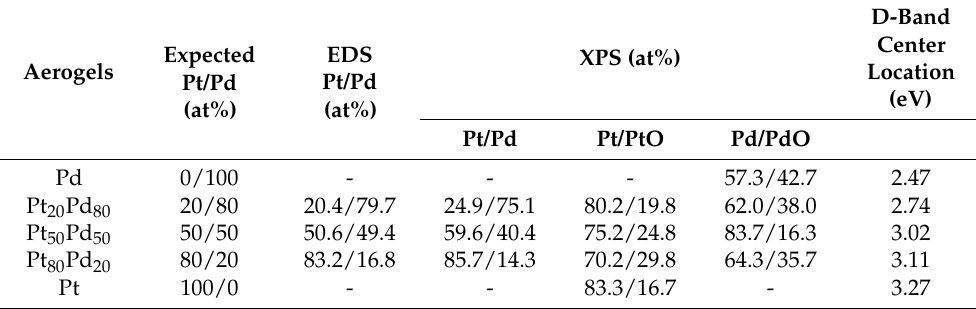
Table 1. Molar ratio of Pt/Pd and metal/metal oxides in the Pt x Pd y aerogels revealed from EDS and XPS and location of the d-band center of all the aerogels.